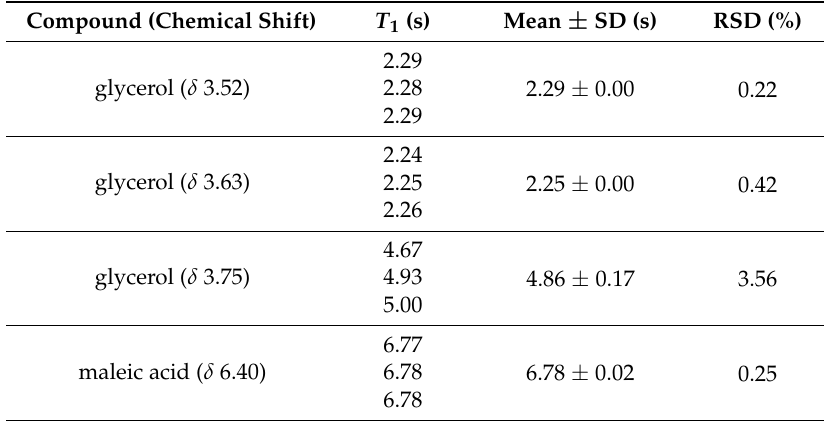
Table 2. Proton T 1 values of glycerol and maleic acid ( n =